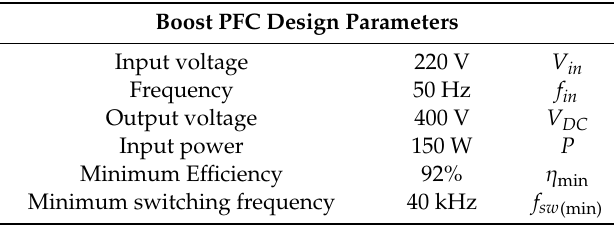
Table 1. Parameters of boost PFC